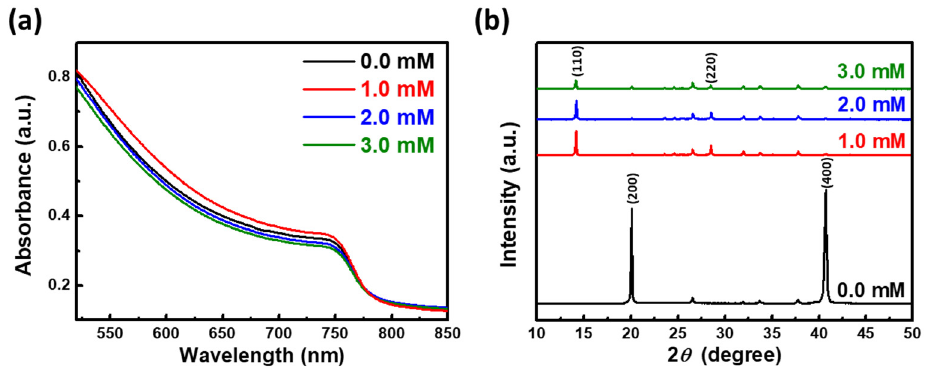
Figure 2. ( a ) UV–vis absorption spectra and ( b ) XRD patterns of pristine, 1.0, 2.0, and 3.0 mM Tween 20 perovskite films.